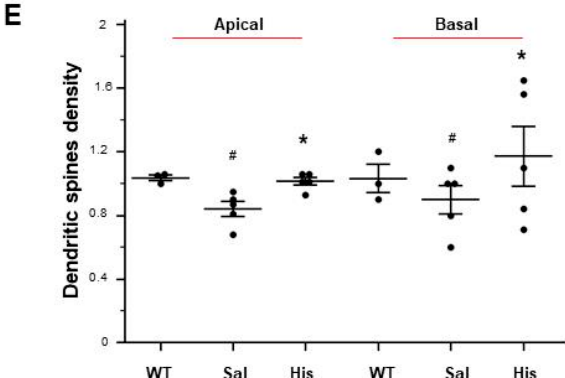
Figure 4. Histidine increases Hsp70 and GRP78 and dendritic spine density in the cortex of symptomatic SOD1-G93A mice. Representative western blots and quantification of Hsp70 ( A ) and GRP78 ( B ) in saline ( n = 4) and 100 mg / kg histidine-treated ( n = 5) SOD1-G93A mice. GAPDH was used as a loading control. Representative images of Golgi-stained motor cortex ( C ), 5 × magnification; Scale bar: 50 µ m) and of dendritic segments (apical and basal) of Layer V M1 pyramidal neurons from WT, saline ( n = 4) and 100 mg / kg histidine-treated ( n = 5) SOD1-G93A mice ( D ), 100 × magnification; Scale bar: 5 µ m); spine density (n spines / µ m) was counted in apical and basal compartment of Layer V pyramidal neurons of M1 ( E ). Data represent mean ± S.E.M. Statistical significance was calculated by ANOVA, as referred to WT, # p < 0.05 or to SOD1-G93A saline-treated mice, * p < 0.05.